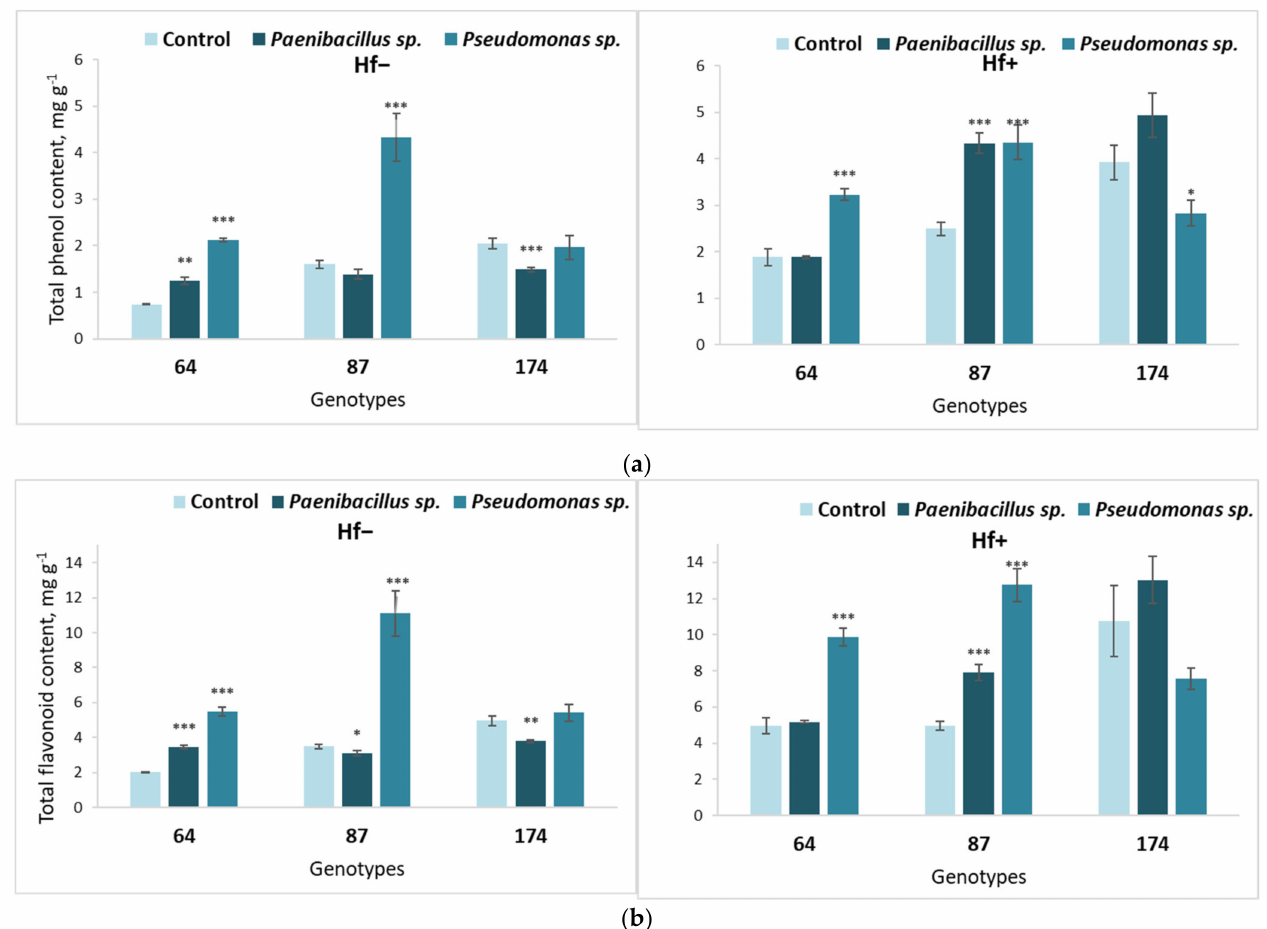
Figure 8. Average TPC ( a ) and TFC ( b ) in the leaves of different F. excelsior genotypes (64, 87 and 174), of which explants were first cultured on the nutrient medium inoculated with Paenibacillus sp. or Pseudomonas sp. bacteria, then transferred onto fresh nutrient medium, either sterile (‘Hf − ’) or inoculated with the fungus H. fraxineus (‘Hf+’). Statistically significant differences from the control variant, which was not treated with bacteria during the first culture stage, are indicated (for each genotype separately): * p < 0.05; ** p < 0.01; *** p <